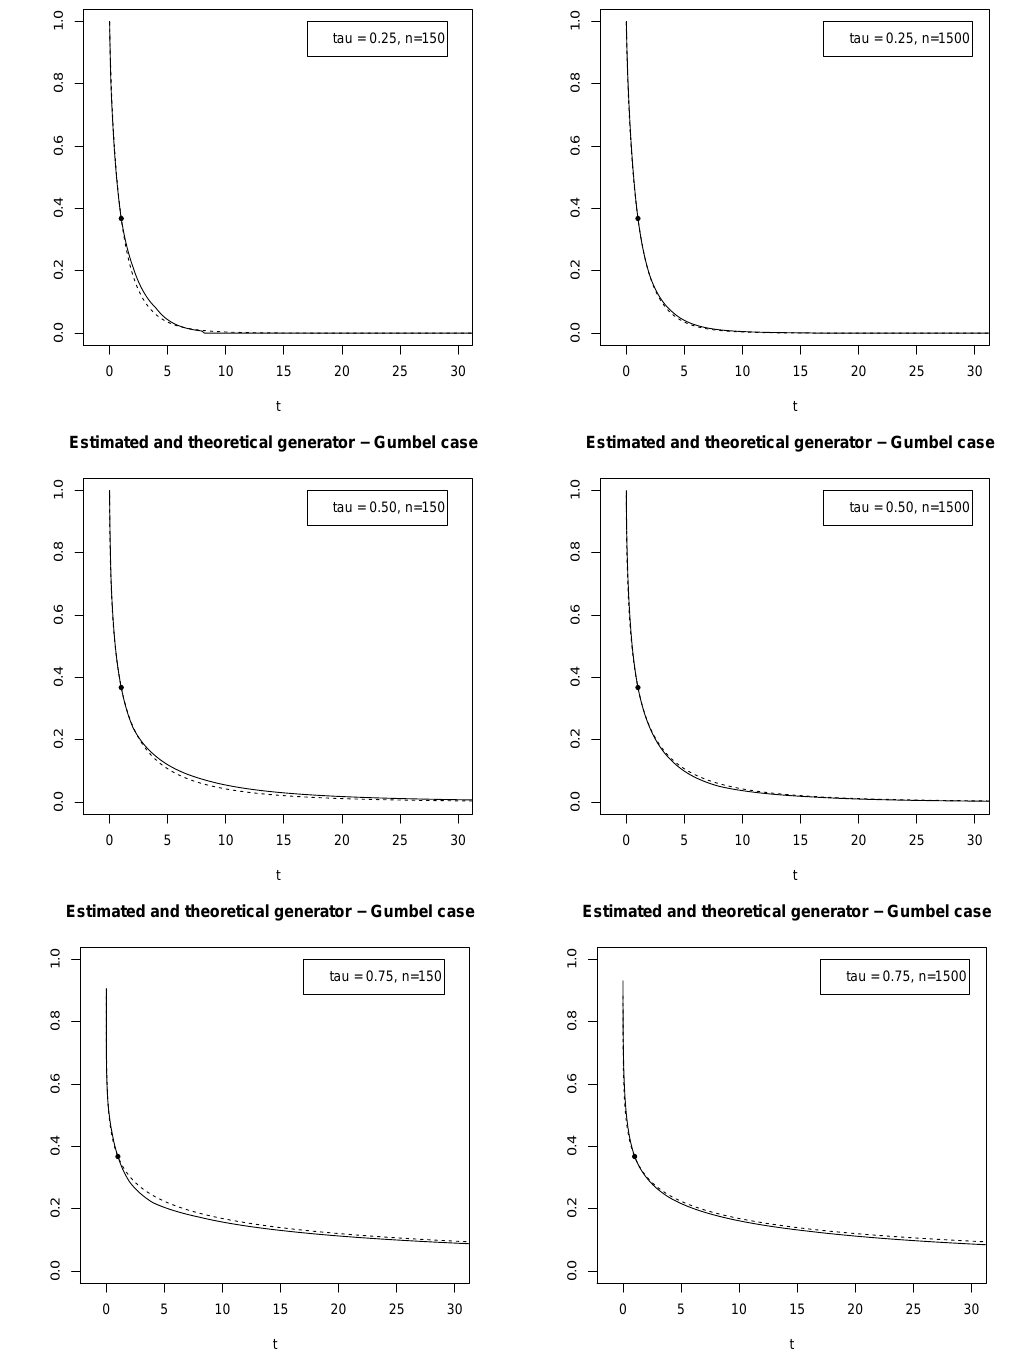
Figure 5. Estimated versus theoretical Gumbel-generator with Kendall’s τ and n = 1500 (right column). Estimated b φ ( t ) = b δ ρ i.e., ¯ φ ( t ) = exp( −t 1 /θ ) , is drawn using a dashed line. We force the generators to pass through the point ( t